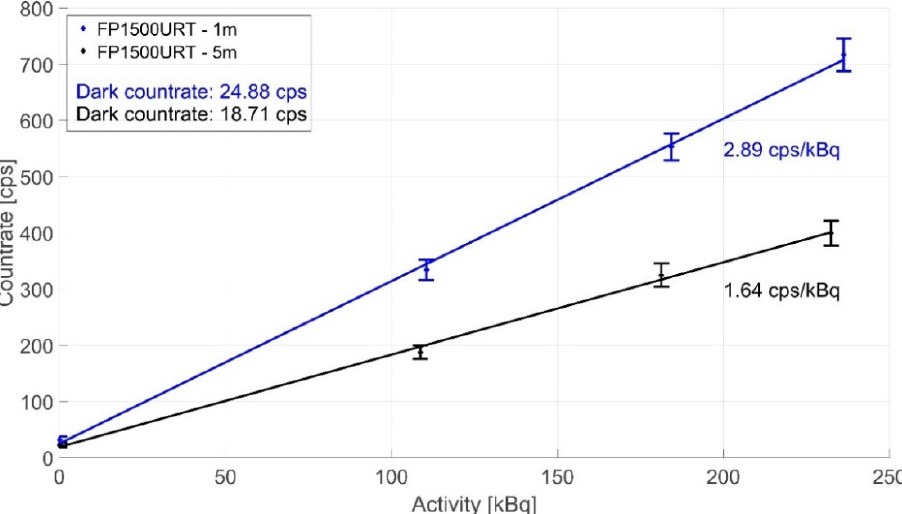
Figure 9. Dosimeter measurement sensitivity decreasing in scintillation radiation delivery with different lengths of the optical fibre link (FP1500URT silica optical fibre) during irradiation of ID1–ID3 sources.